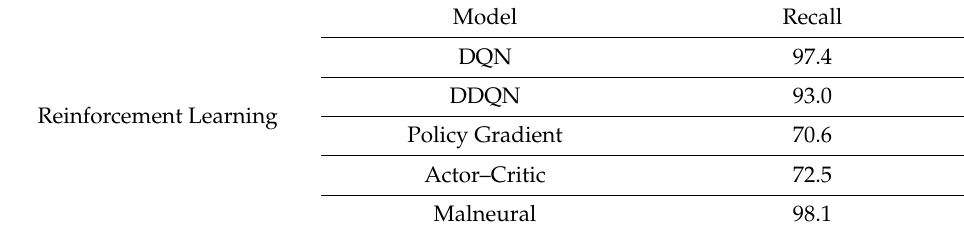
Table 12. Recall calculation for monkeypox disease detection results using the reinforcement learning